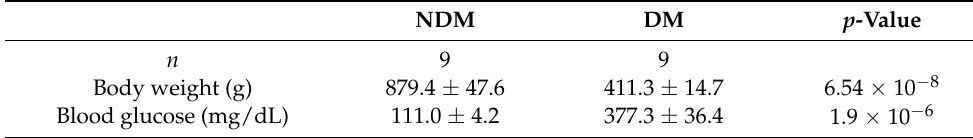
Data are shown as mean ± SE. NDM = non-diabetes mellitus; DM = diabetes